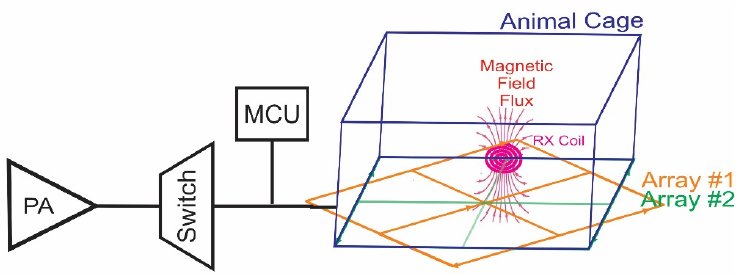
Figure 6. Schematic of measurement setup for proposed array configuration. The orange and green array are the first and second TX array swOitch respectively.